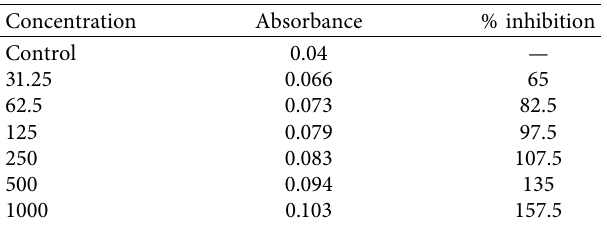
Table 8: Absorbance of ethanolic extract of Artocarpus hirsutusn Lam leaves at 660nm.